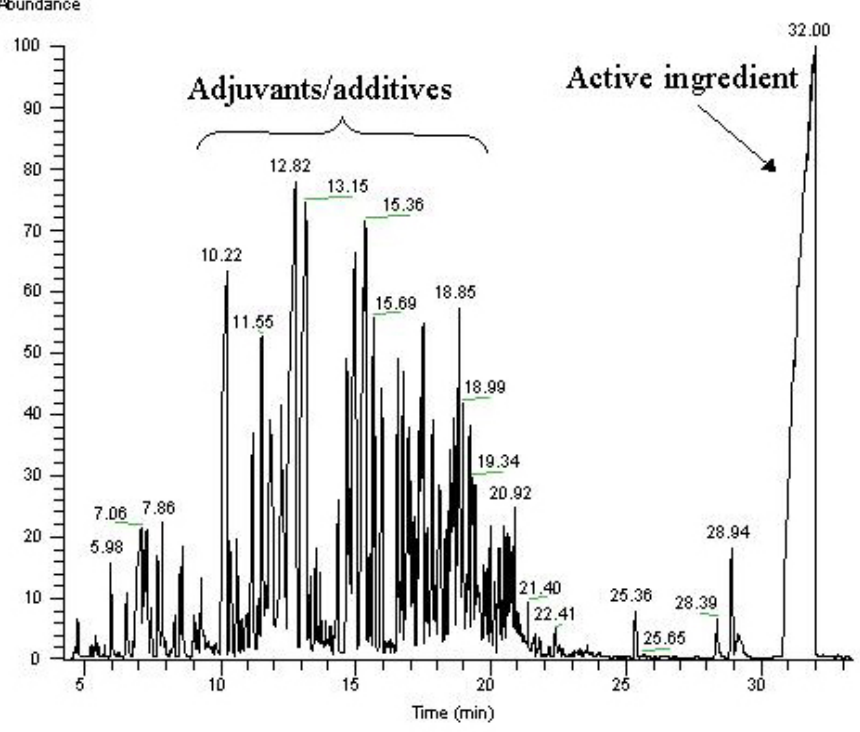
FIGURE 1. GC-EI-MS chromatogram of a formulated pesticide in which the active ingredient elutes at 32 min. Peaks from min. 10 to 21 correspond to pesticide adjuvants (surfactants, etc.).